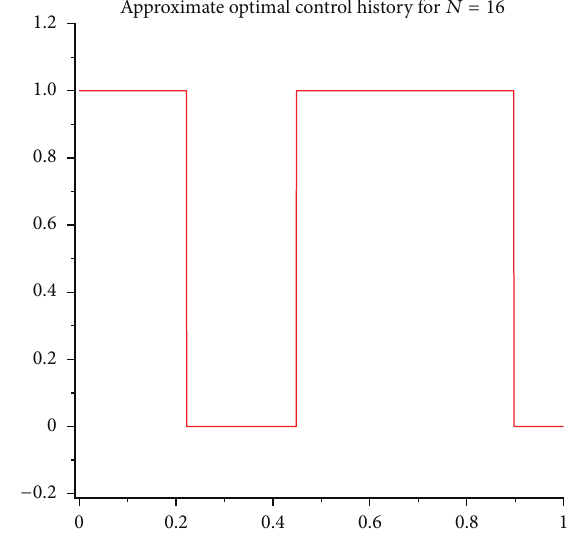
Figure 4: Approximate optimal control 𝑢(𝑡) history of Example 2 for 𝑁 = 16 .